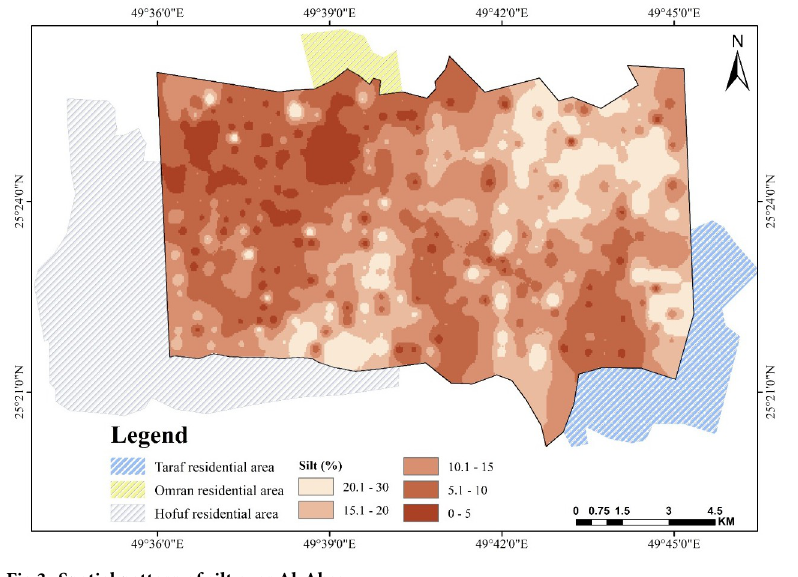
Fig 3. Spatial pattern of silt over